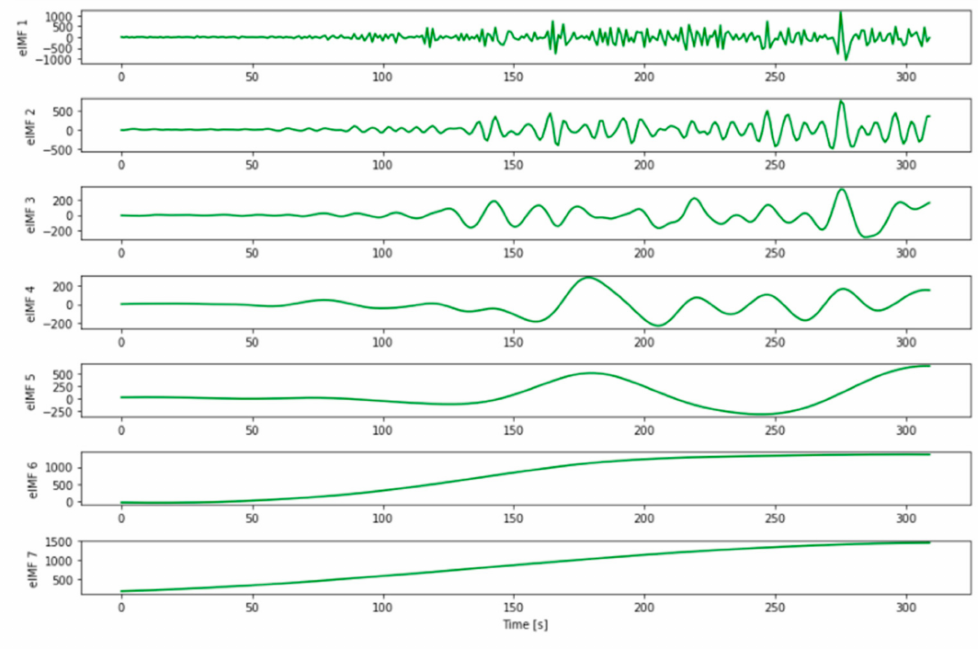
Figure 1. IMFs generated for Alabama.